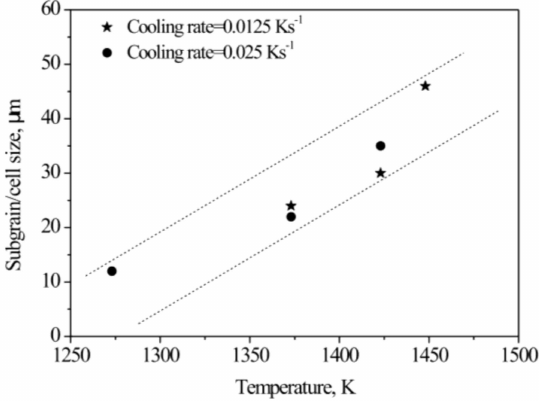
Figure 4. Relationship between subgrain/cell size and final temperature of deformation.